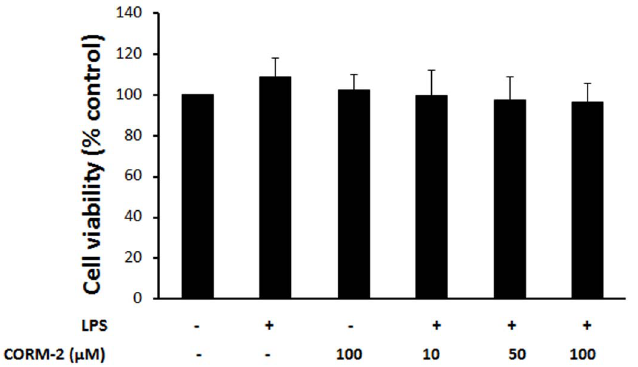
Figure 1. Effect of CORM-2 on cell viability. IEC-6 cells were treated with CORM-2 in the absence or presence of LPS (/ml) for 24 h, and cell viability was assessed using the MTT assay. Results are the mean 6 SD of 3 independent experiments. ANOVA test P . 0.05.